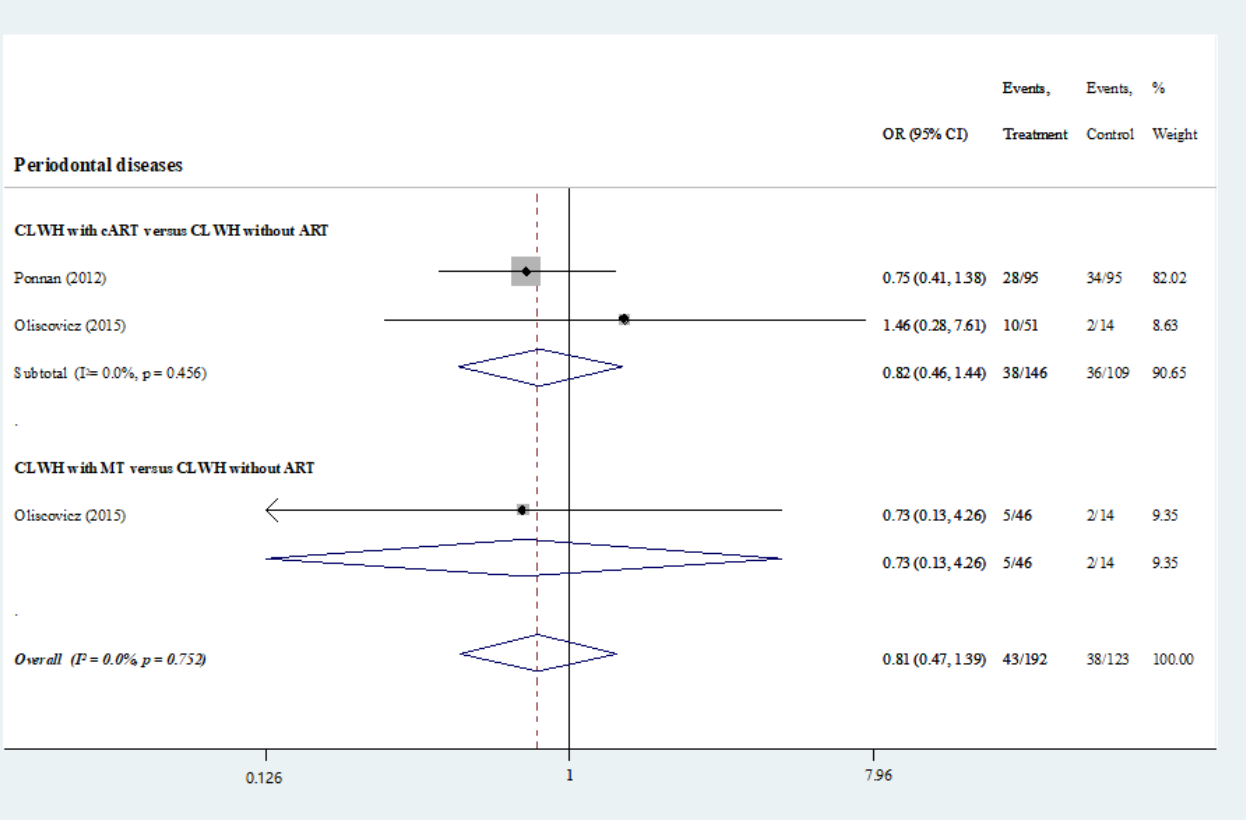
Figure 3. Prevalence of periodontal diseases. CLWH under ART versus those without medications